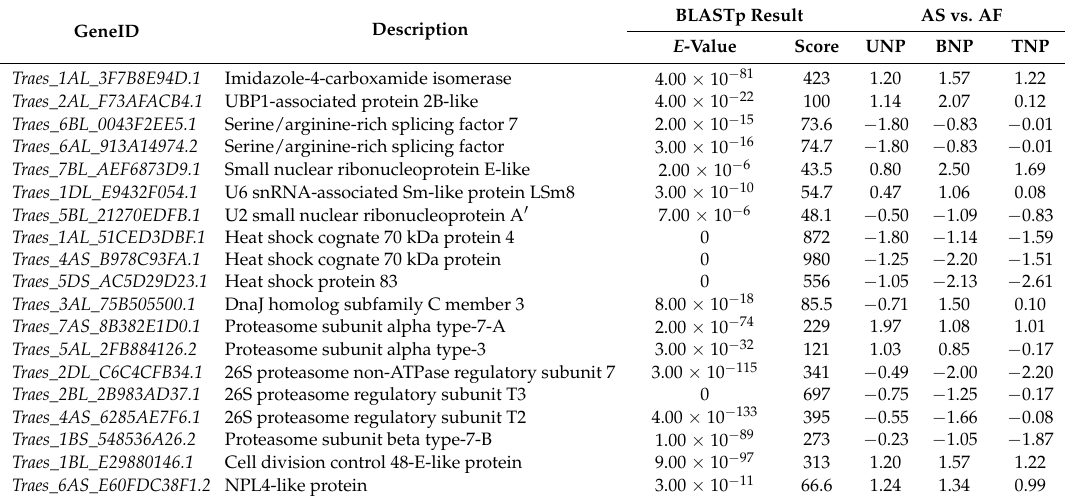
Table 5. Differentially abundant proteins related to protein synthesis and degradation in fertile and sterile